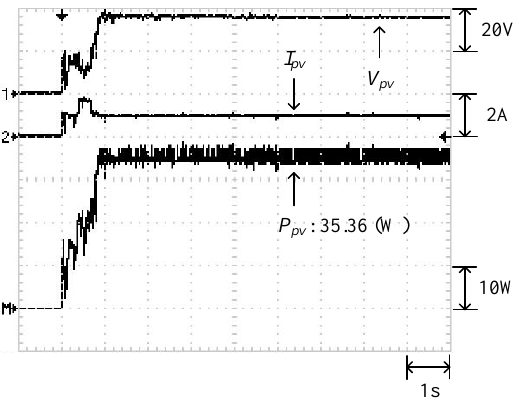
Figure 9. P–V characteristic curve of Case 1.